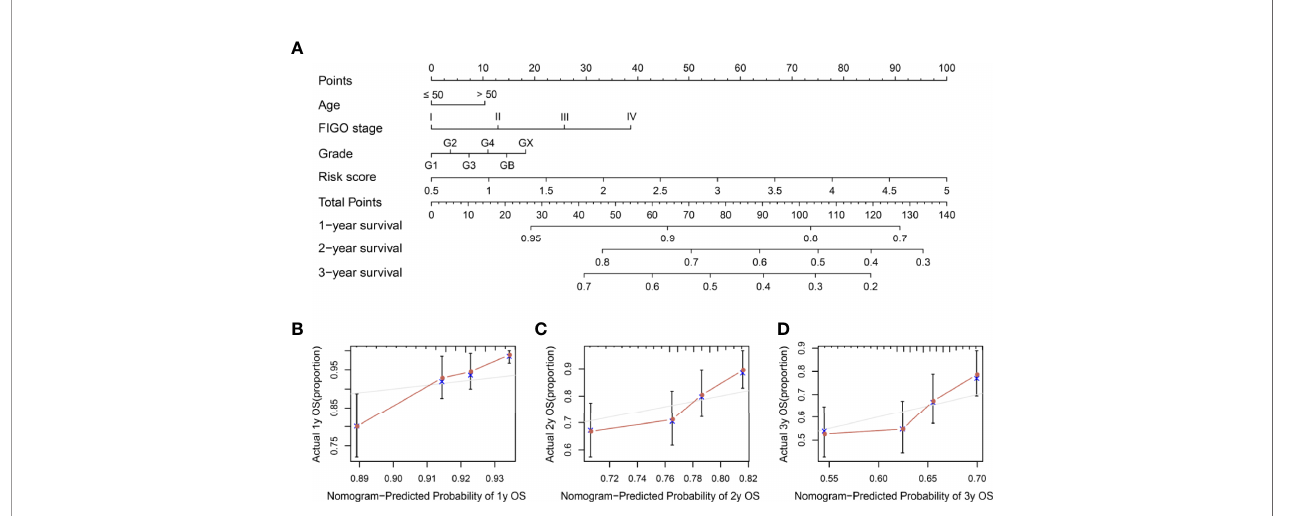
FIGURE 7 | Nomogram construction and visualization. (A) A nomogram constructed using risk score and clinical characteristics in SOC patients within 1-, 2-, and 3-year OS data. (B – D) Calibration plots of actual and predicted 1-, 2-, and 3-year OS in the entire